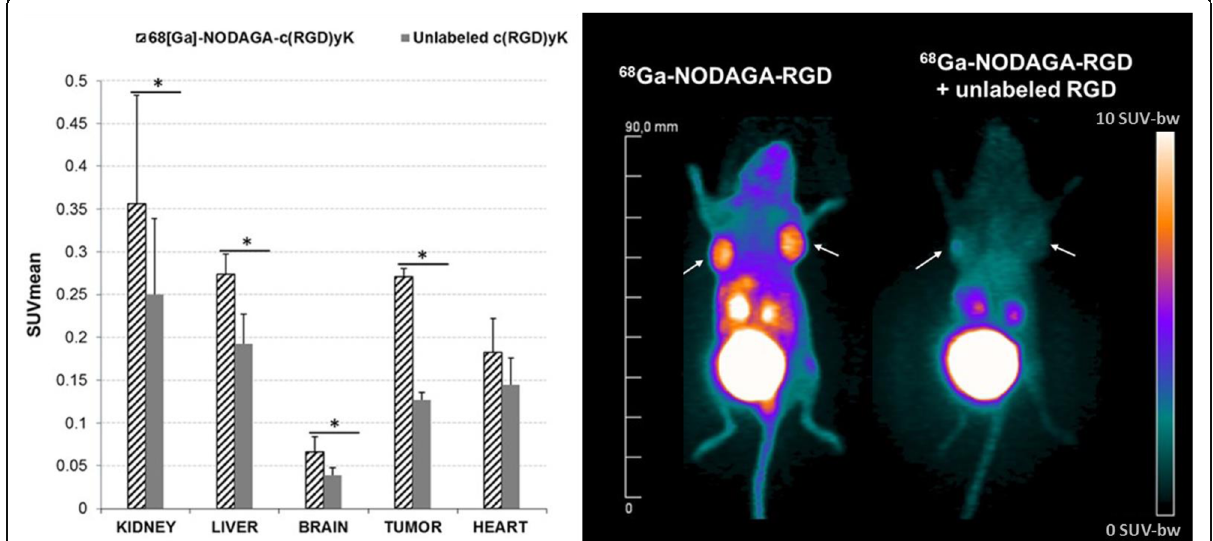
Fig. 2 Results of blocking experiments performed in five xenograft mice: a with SUVmean values obtained at the 2 nd hour of PET recording for tumors and various organs, after the injection of 68 Ga-NODAGA-RGD (black hatched bar), as compared with the co-injection of 68 Ga-NODAGA-RGD with excess unlabeled RGD (gray bars) and b with examples of superimposed Maximal Intensity Pixel images obtained in the same animal with 68 Ga-NODAGA-RGD alone (left image of mice) and with 68 Ga-NODAGA-RGD co-injected with unlabeled RGD (right image of mice). The two tumors are indicated with white arrows and the color scale is expressed in SUV values. * p <0.05 for paired comparisons